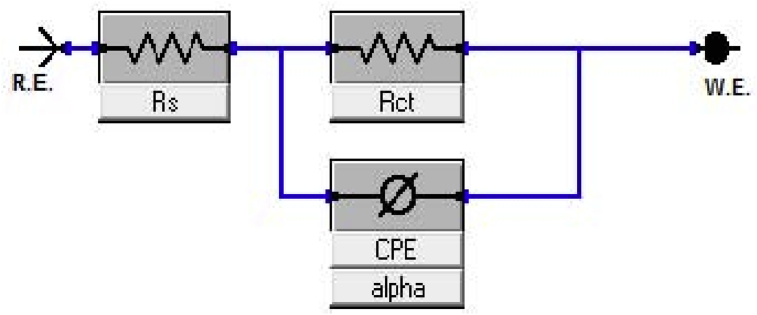
Equivalent circuit for fitting EIS data showing the positions of CPE, Rct and Rs[87].